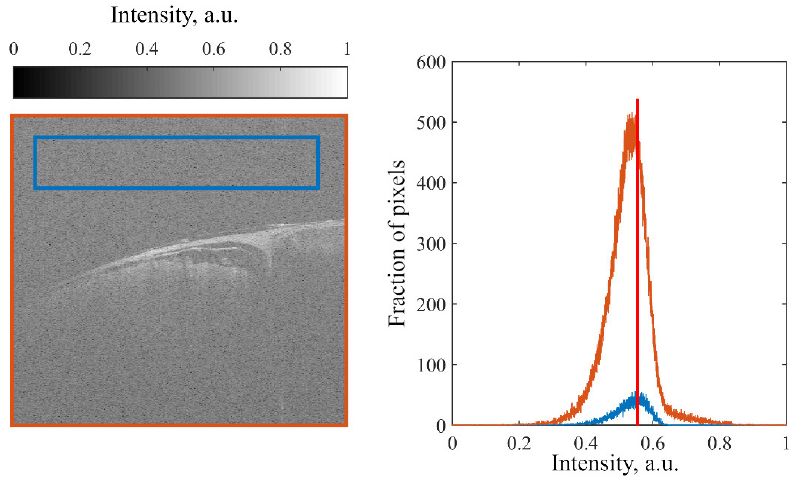
Fig. 10. A comparison between whole B-scan histogram and a histogram of background noise.